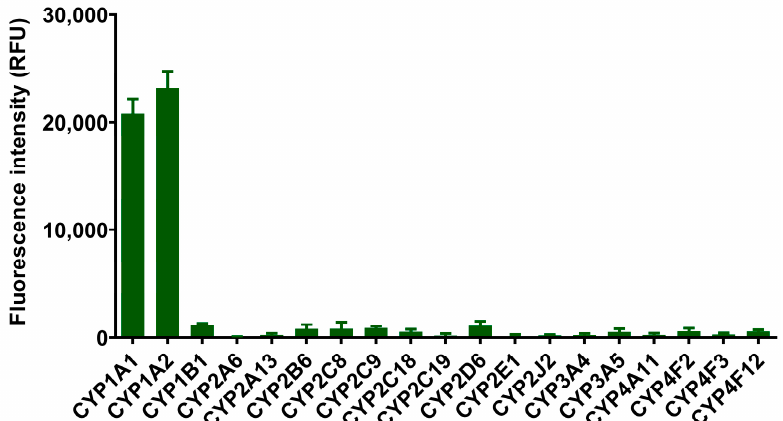
Figure 2. Fluorescence response of ERNM that incubated with different subtypes of human CYPs. Data are shown as the mean ± SD.